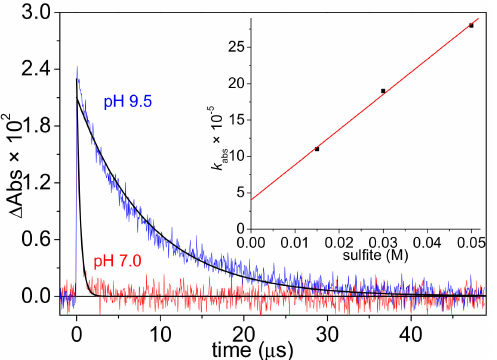
Figure 5. Kinetics of decay of e aq − absorption at 720 nm at pH 7 and 9.5. Smooth black curves are the monoexponential best fits with lifetimes of 0.43 and 8.6 µ s, respectively. Insert: dependence of k obs720 nm at pH 7 upon sulfite